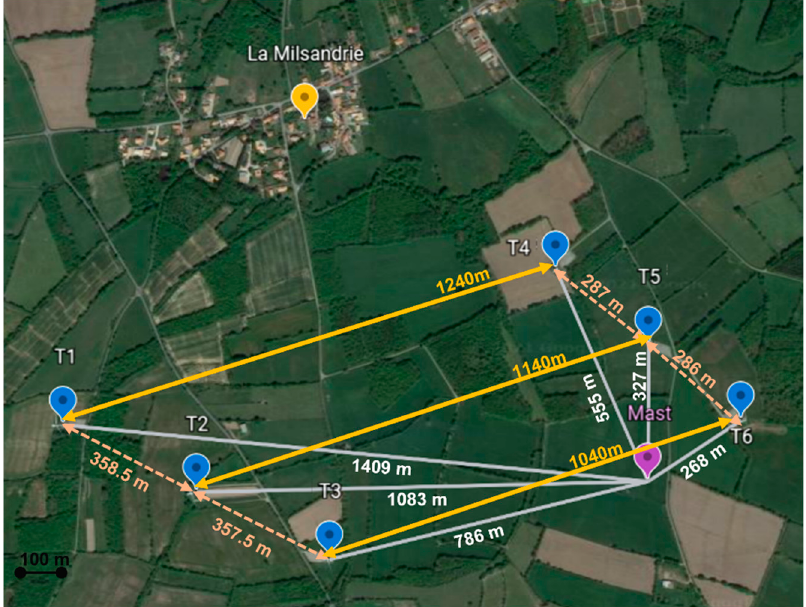
Figure 3. Localization of the six wind turbines (T1, T2, T3, T4, T5, and T6) indicated by the blue marks. The instrumented mast is pointed out by the purple mark. The distances between the turbines are indicated by the yellow (dashed and full) arrows. The distances between each turbine and the mast are indicated by the grey lines. The geographical coordinates of the mast are 47.090 ◦ N, 1.906 ◦